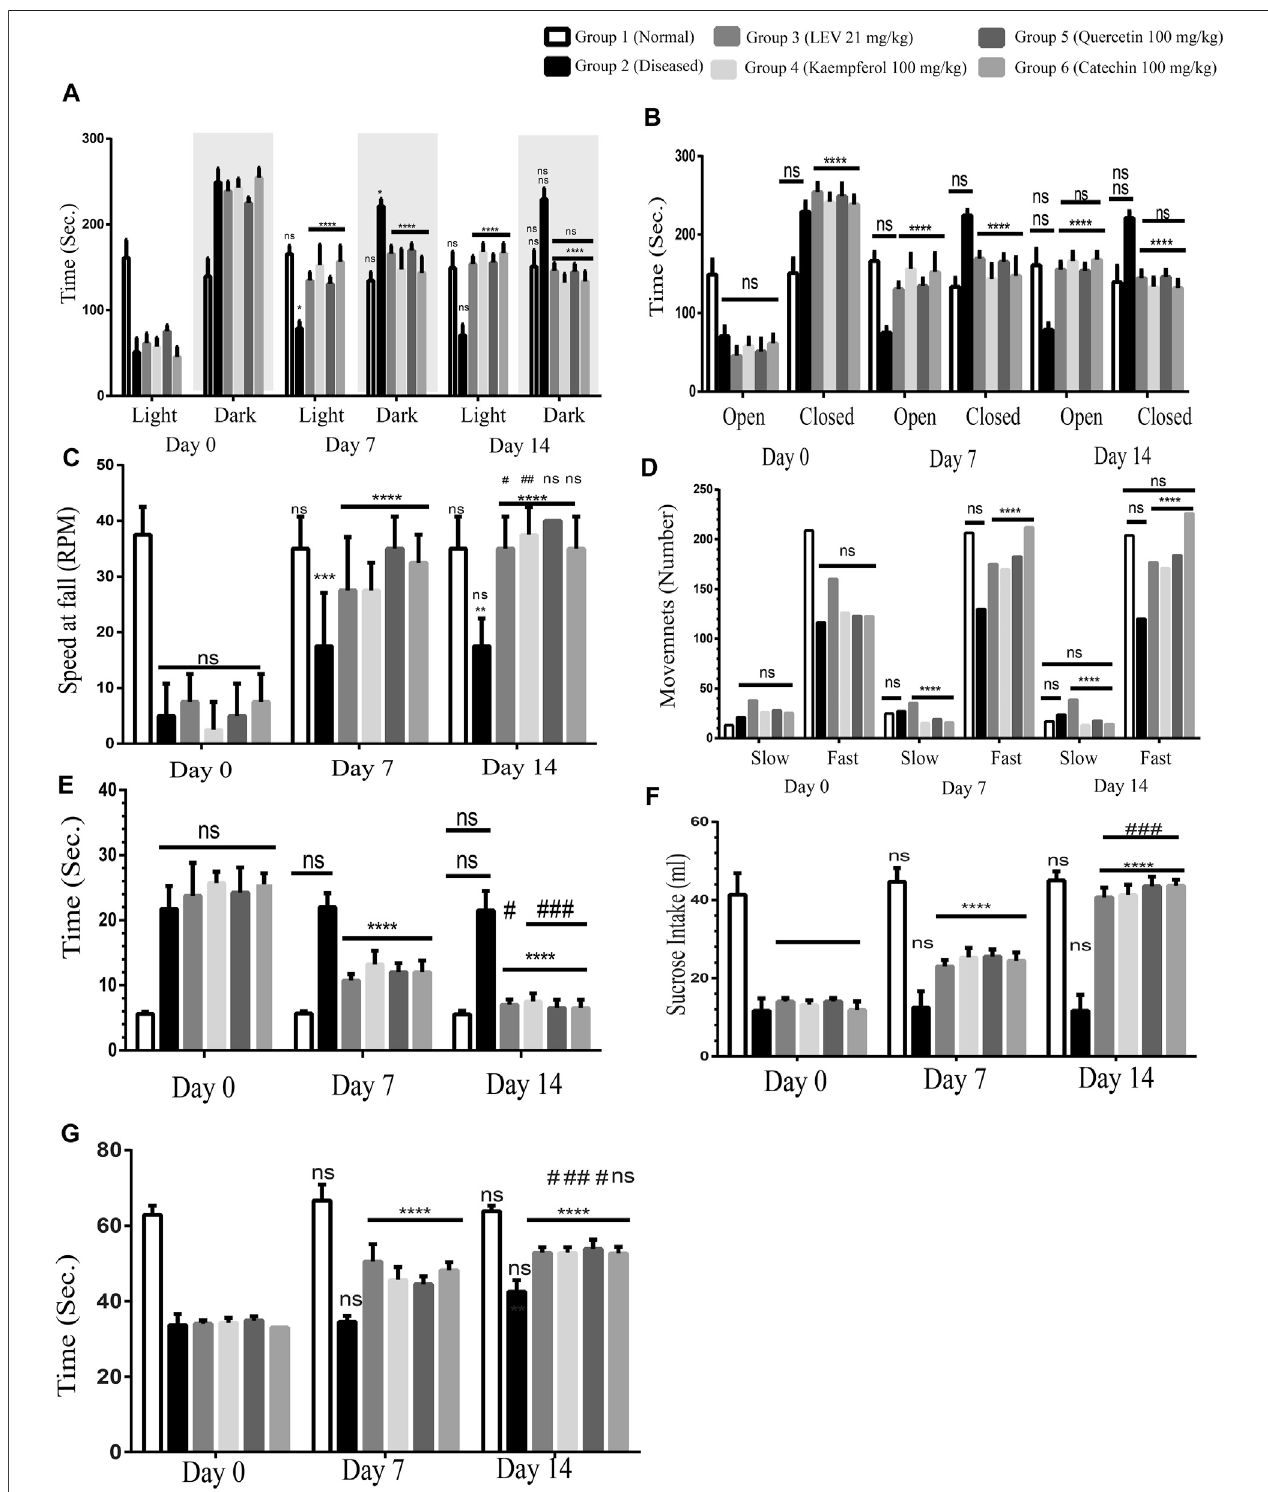
FIGURE 4 | (A) Light and dark model, Day 0: diseased rats were non-signi fi cant in all the groups showing the proper induction of the disease in all the rats. 7- and 14-Daytreatment inbothstandardtreatedand others; phytochemicals(100 mg/kg) signi fi cantlyreducedthetime spentinthedarkerarea, andmore time isspent inthe lightarea. ANOVA, F(5/42) (cid:2) 2.33, con fi rmed signi fi cant improvement inthe behavior at Day 14 among the groups and also betweentwo time points (Day7 vs Day 14 # )